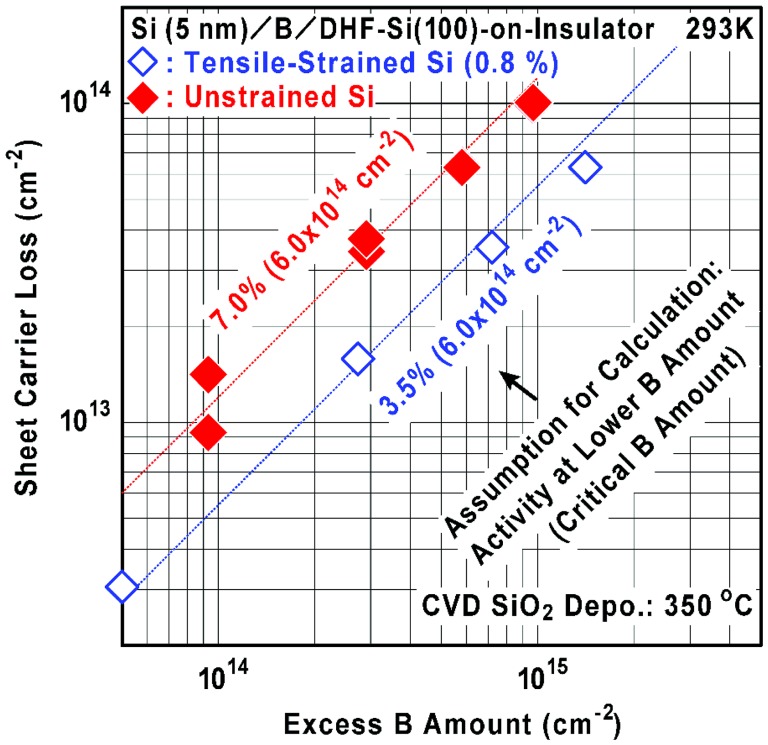
Relationships between excess B amount and sheet carrier loss calculated using the data shown in Figure 7(a) when a specific electrical activity at lower B amount (7% and 3.5%) and a specific critical B amount (6.0 × 1014 cm−2) are assumed.